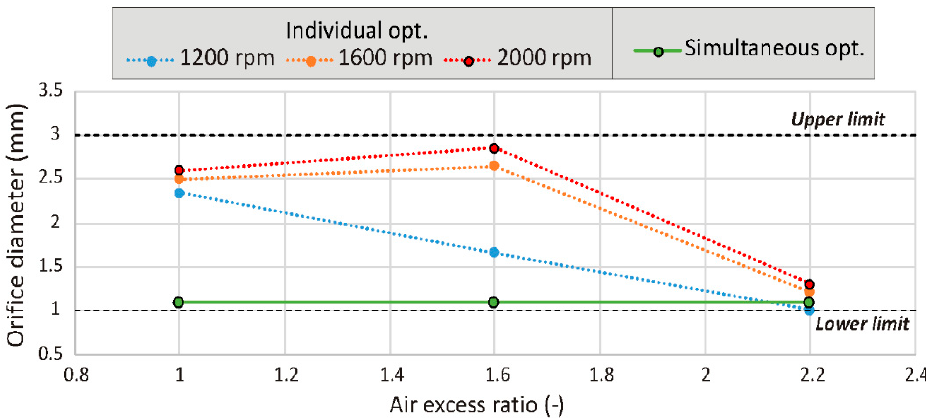
Figure 13. Optimized orifice diameters for individual and simultaneous optimization.